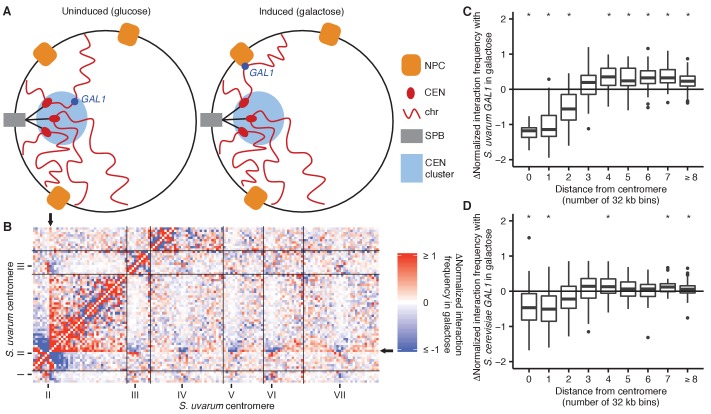
GAL1 shifts away from centromeres upon galactose induction.(A) Schematic of GAL1 positioning (dark blue) in glucose (left) and galactose (right). NPC, nuclear pore complex; CEN, centromere; chr, chromosome; SPB, spindle pole body. (B) Example region of differential Hi-C map of S. cerevisiae x S. uvarum hybrids in galactose vs. glucose, at 32 kb resolution. Interactions that strengthen in galactose are in red, while those that weaken are in blue. Ticks indicate centromeres; black lines indicate chromosomes. Arrows indicate location of S. uvarum GAL1. (C) Boxplot of the difference in S. uvarum GAL1 interaction frequency in galactose vs. glucose across the S. cerevisiae x S. uvarum genome, excluding intrachromosomal interactions and binned by distance from the centromere (in 32 kb bins). Whiskers correspond to the highest and lowest points within the 1.5× interquartile range. *p<0.05 after Bonferroni correction (n = 9); Mann-Whitney test. Note: some outliers are beyond the plot range and are not shown. (D) Same as (C) for S. cerevisiae GAL1.